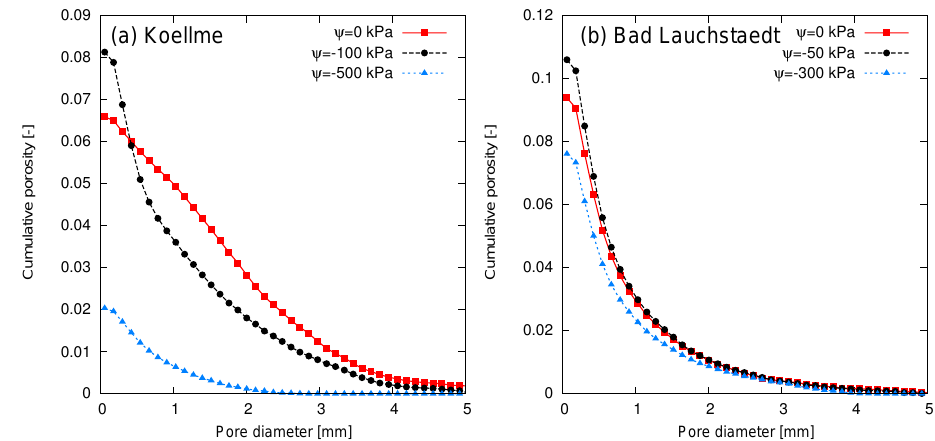
Figure 3. Cumulative pore size distribution ( > 61µm) in the Köllme soil (a) and the Bad Lauchstädt soil (b) at three different capillary pressures. Values are derived with the maximum inscribed sphere method and correspond to porosity larger than a specific pore diameter.